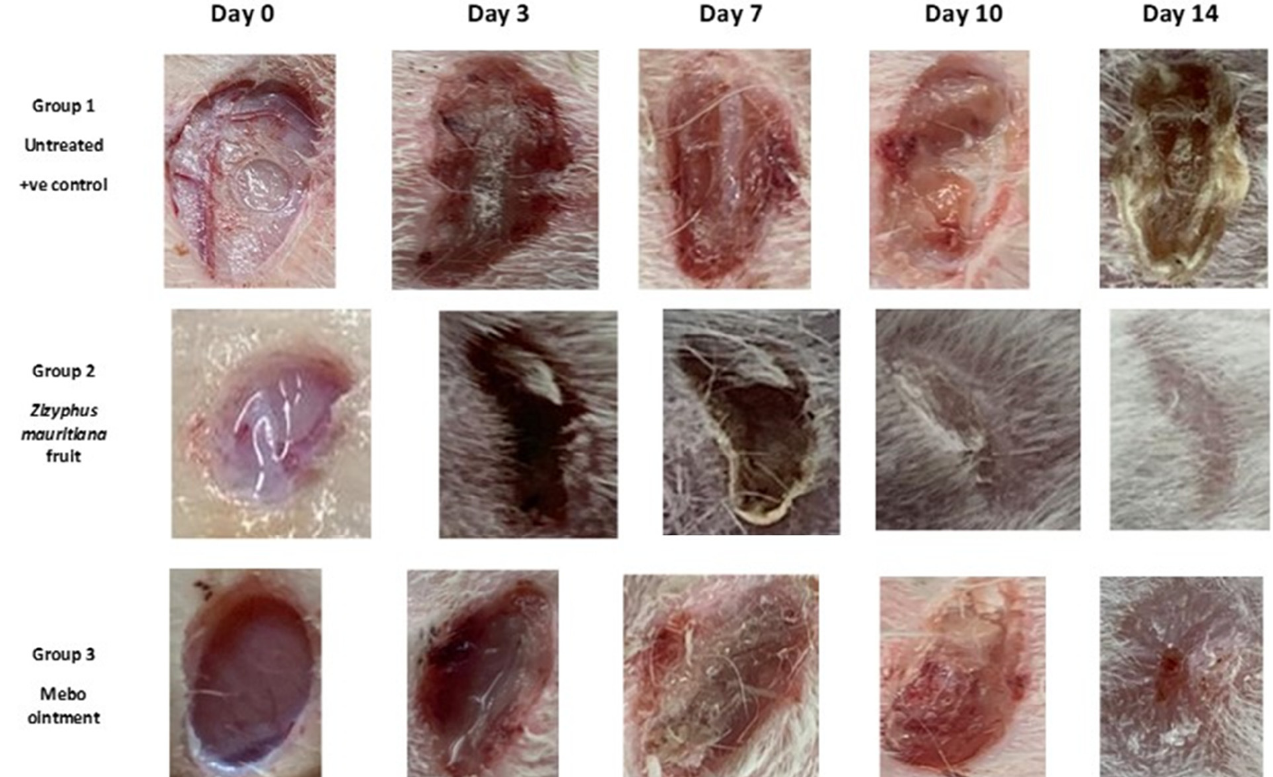
Figure 3. The excisional wounds on days 0, 3, 7, 10, and 14 post-wounding results of the activity for Z. mauritiana fruit extract and MEBO ® in wound of adult male New Zealand Dutch strain albino rabbits: Group 1: untreated (Negative control), Group 2: ZFE-treated group, and Group 3: MEBO ® -treated group (Positive control).